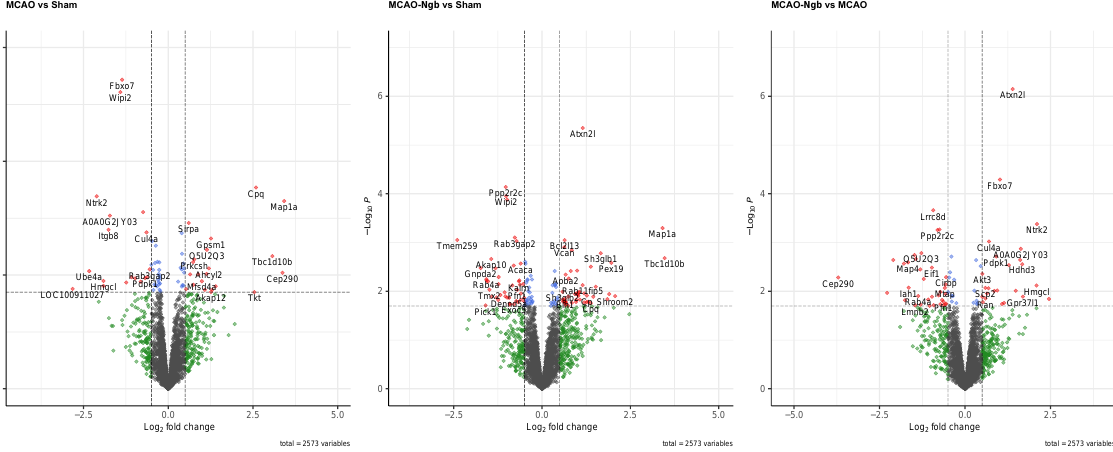
Figure 11. Volcano plots for the three comparisons using p < 0.02 and Log2 fold change of 0.5 as threshold. When comparing MCAO vs. sham, proteins FBXO7, WIPI2, NTRK2, A0A0G2JY03, and ITGB8 are underexpressed, whereas MAP1a and CPQ are overexpressed. In the comparison between MCAO-Ngb and sham, proteins PPP2r2c, WIPI2, and LRRC8d are shown to be underexpressed, whereas ATXN2l, MAP1a, and TBC1d10b are overexpressed. The comparison between MCAO-Ngb and MCAO involves the over expression of ATXN2l, FBXO7, and